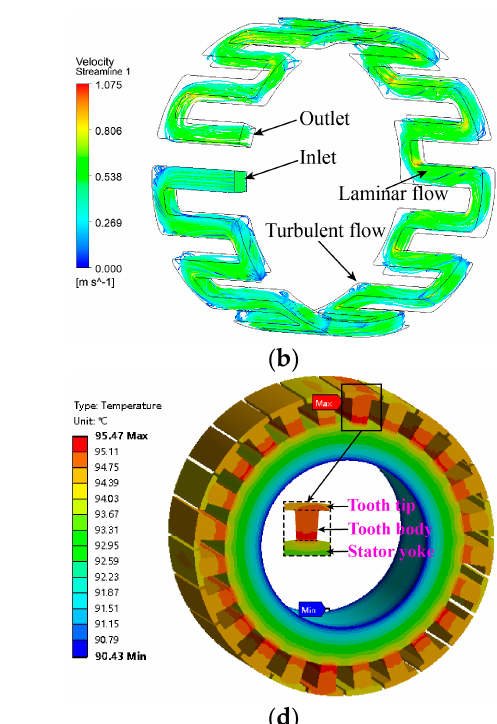
Figure 11. Configuration and main parameters of U-type waterways.